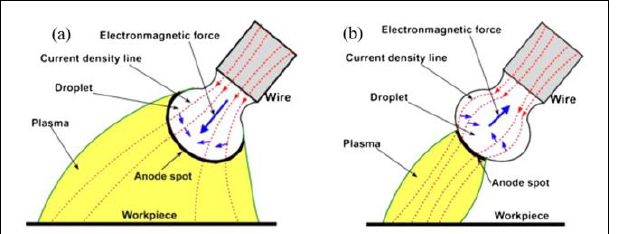
Figure 20. Variation of electromagnetic force and current density line distribution with plasma state: ( a ) MIG welding; ( b ) Laser-MIG hybrid welding [94]. Reprinted with permission from [94] 2012 Elsevier.